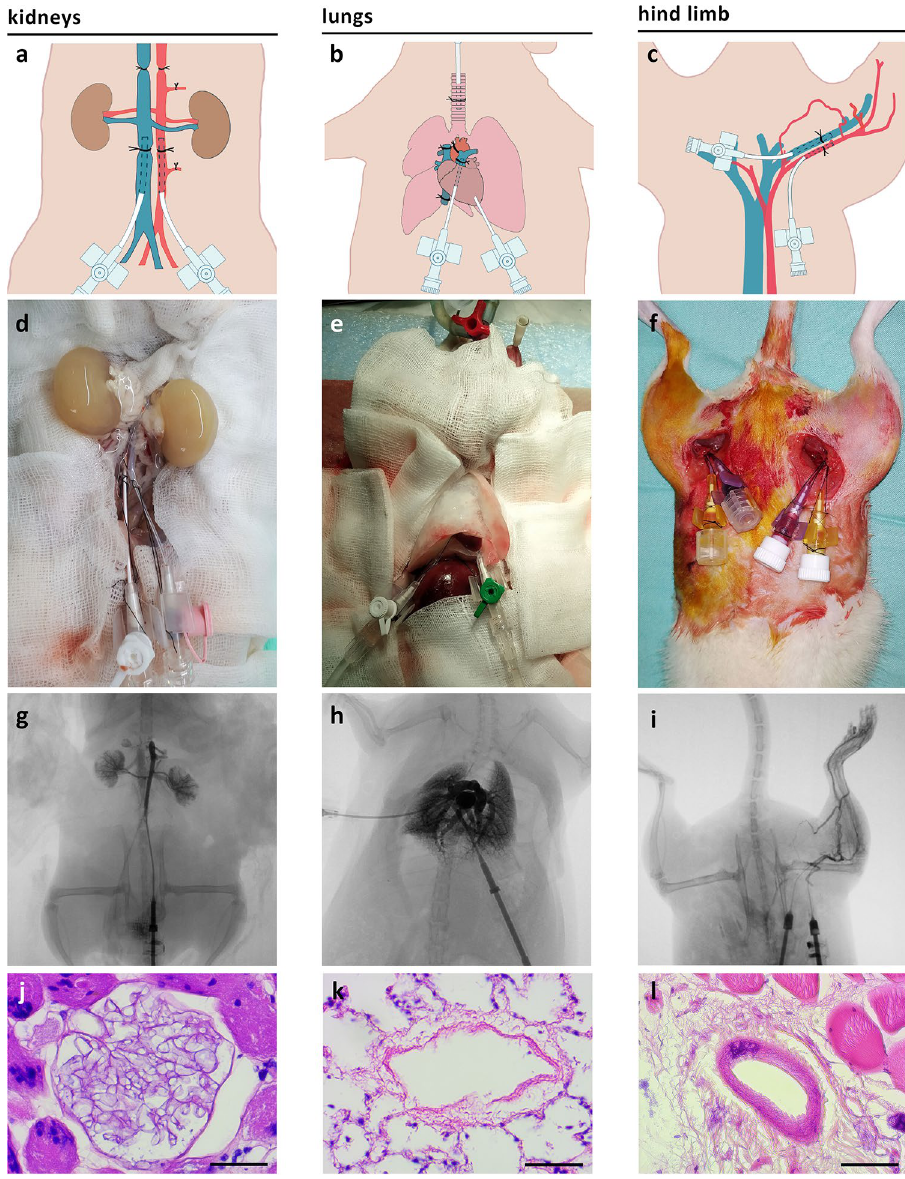
Figure 4. Isolated perfusion and vascular decellularization of rat organs in situ. Illustrations of isolated organ perfusion technique ( a–c ), corresponding photographs ( d–f ) angiographic images ( g–i ), and histological analysis ( j–l ) of rat kidneys, lungs, and hind limbs, respectively. Scale bars, 100 µm ( l ) and 50 µm ( j , k ). (Illustrations by Noa First